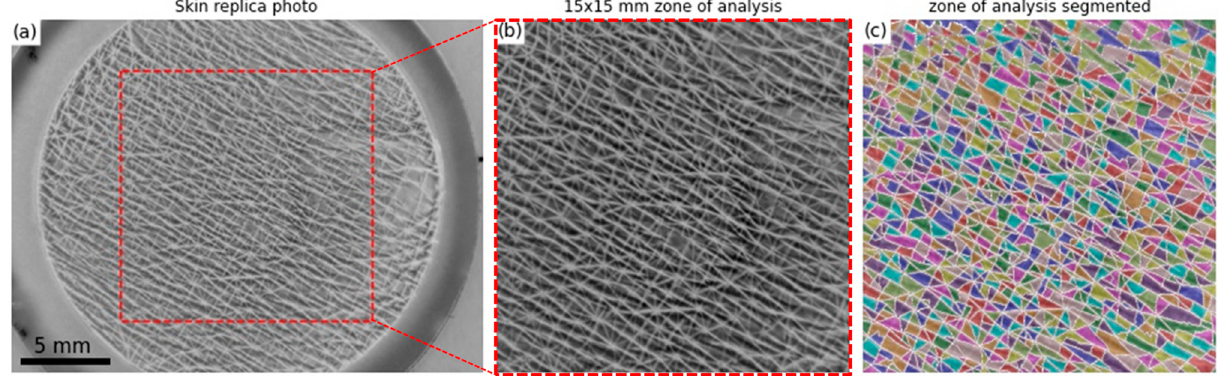
Figure 1. ( a ) HQ skin replica picture ( b ) Crop of a 15 × 15 mm zone of analysis in the central part of the photo ( c ) Results of Marker ‐ Controlled Watershed